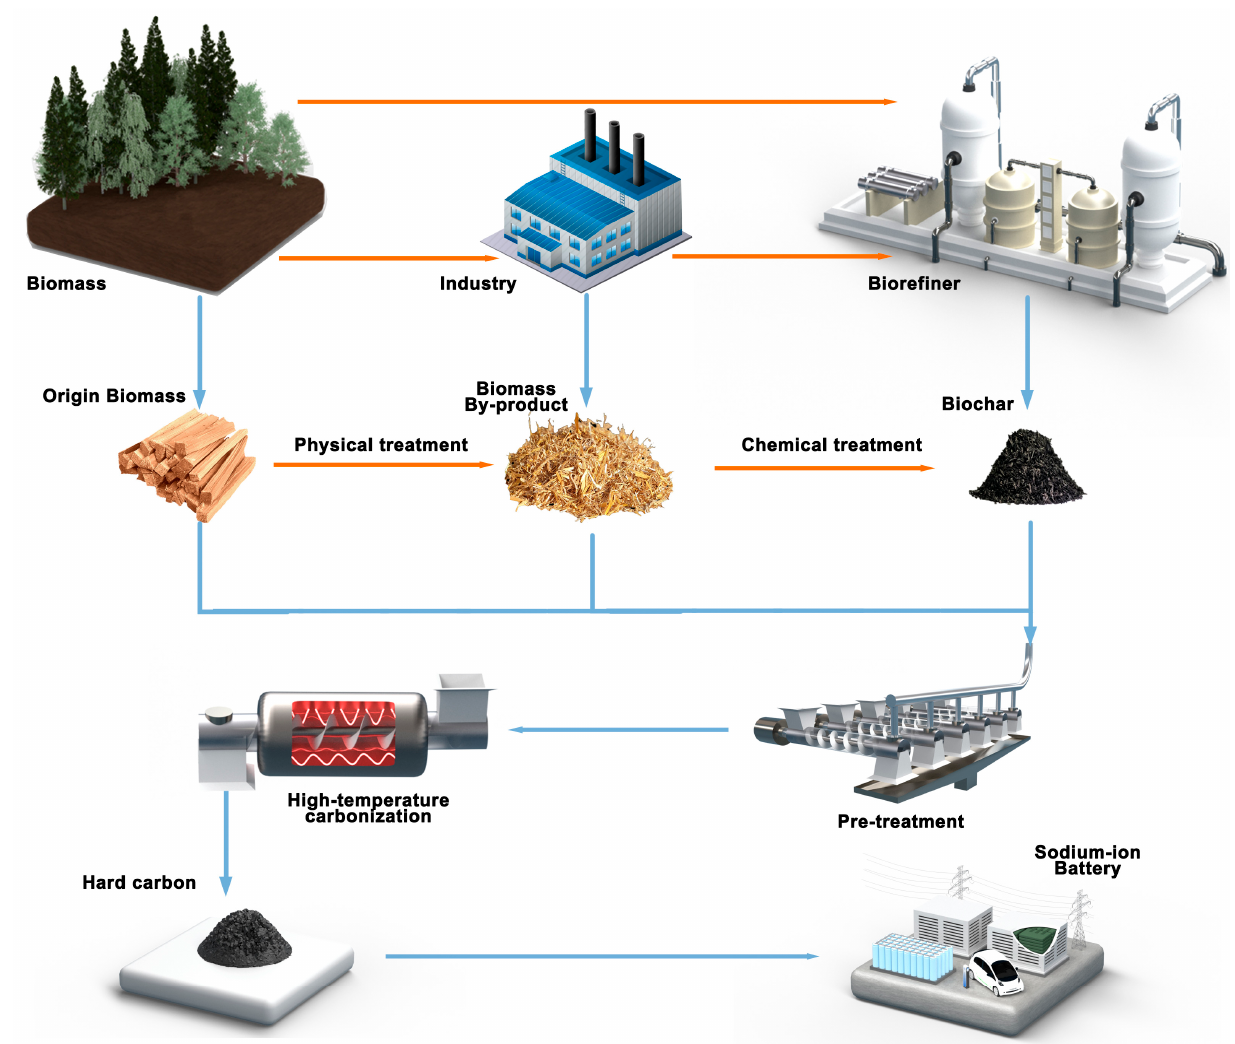
Figure 2. Processes involved in the production of hard carbon from biomass.